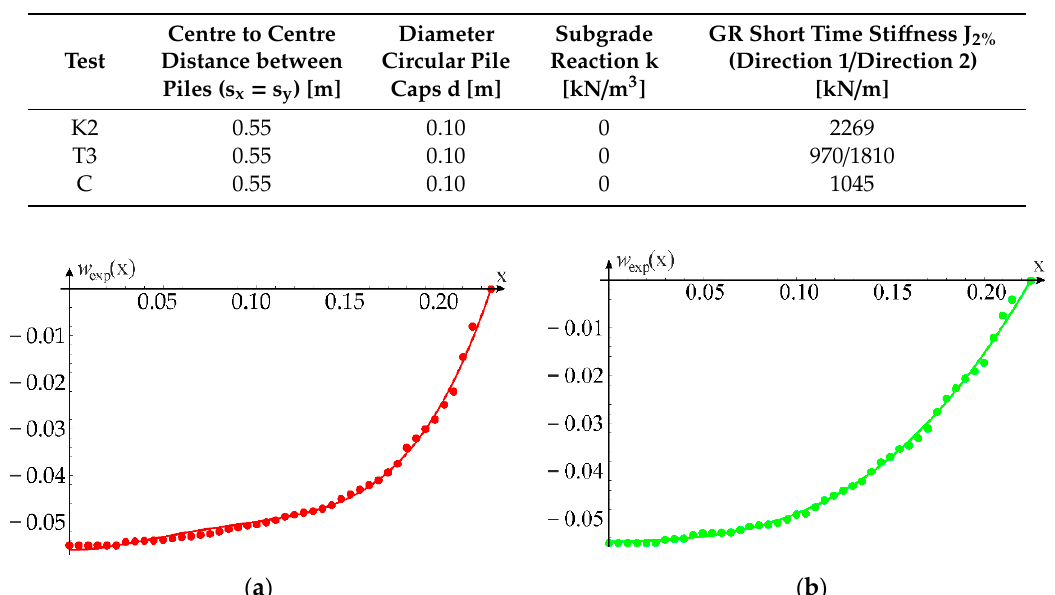
Figure 6. Results of settlement measurements for tests K2, T3 and C [9,10]. French experiments. Briançon and Simon [13] and Nunez et al. [37] reported a series of large-scale tests in four test fields 1R–4R. Reinforcement was used only for plots 3R and 4R, PET biaxial geotextile in case of 3R and two layers of biaxial geogrid in case of 4R. The soft soil was improved with columns 0.38 m in diameter at an axial distance of 2 m. The measurements of settlements were carried out over a period of about six months. Parameters of the French tests are listed in Table 2.